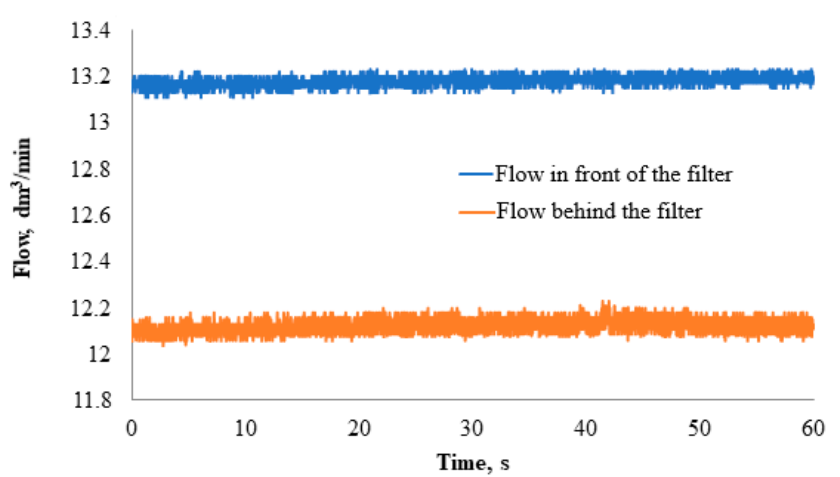
Figure 5. Plot of pressure of uncontaminated oil with CNH Industrial 2992242 filter at 30 °C.